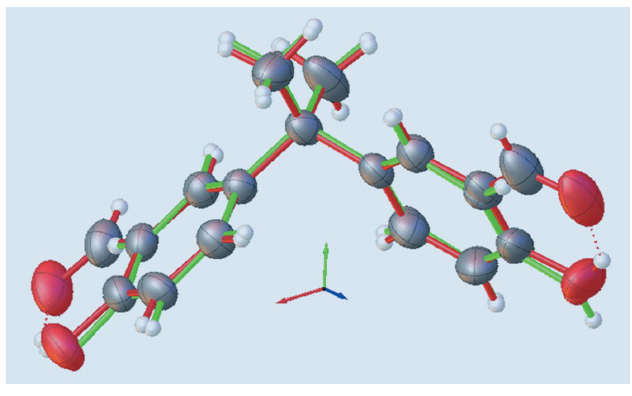
Figure 6 Superimposition of the non-hydrogen atoms of ( 3 ) (green) onto the corresponding atoms of ( 1 )